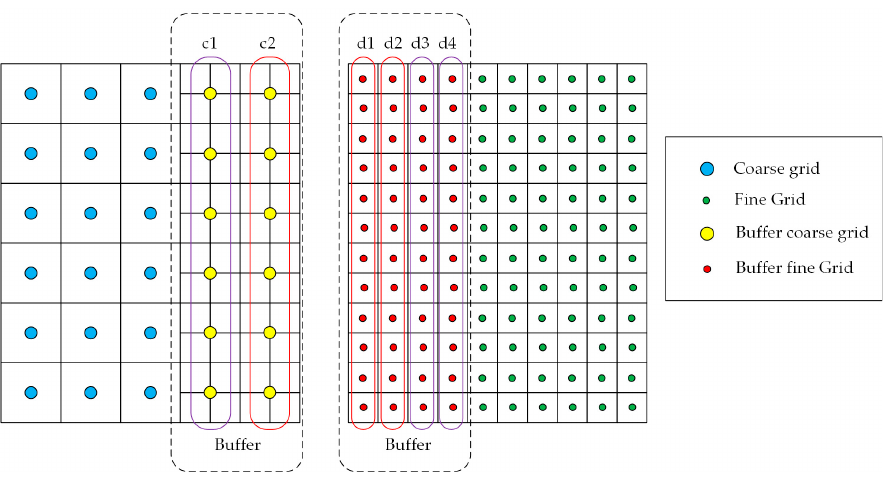
Figure 11. The description of the calculation process of the coarse grid and fine grid in the buffer. After that, the correct distribution function values in column c2 of the coarse grid and the correct distribution function values in columns f1 and f2 of the fine grid can be calculated by spatial interpolation since the current coarse and fine grids are in the same time. The specific data transfer schematic is shown in Figure 12. The yellow triangle in Figure 12 represents the distribution function values on the coarse grid points corresponding to the fine grid region of the buffer calculated by the central interpolation Equation (14), and then the correct distribution function values are transferred to the coarse grid distribution function values represented by the yellow dots in column c2. In this way, the values of coarse grid distribution function in columns c1 and c2 are the correct distribution function values. Similarly, the red triangle in column c1 of the coarse grid in the buffer represents the distribution function values corresponding to the fine grid calculated by the interpolation Equations (15)–(18), which are then transferred to the fine grid distribution function values represented by the red dots in columns d1 and d2. In this way, all the coarse and fine grids are at time δ t , and the distribution functions on all grid points are correct. After that, the calculation of the flow field information can be performed, and then the next time step can be started.